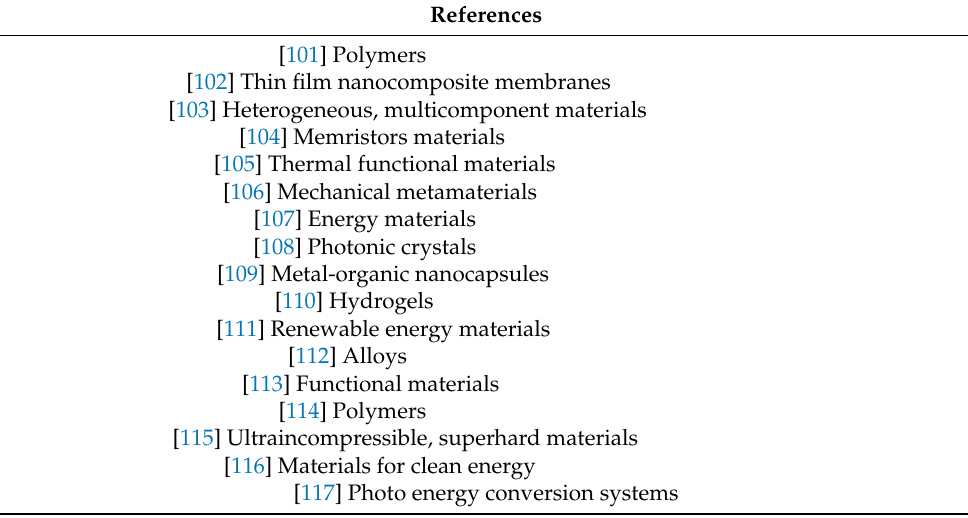
Table 4. Other applications of ML for the design and discovery of diverse